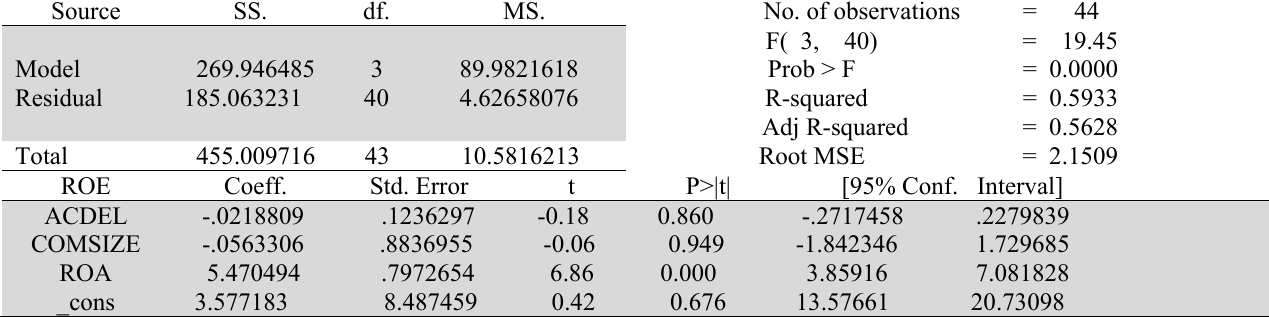
The results of testing the relationship between audit committee diligence and return on equities Source SS.